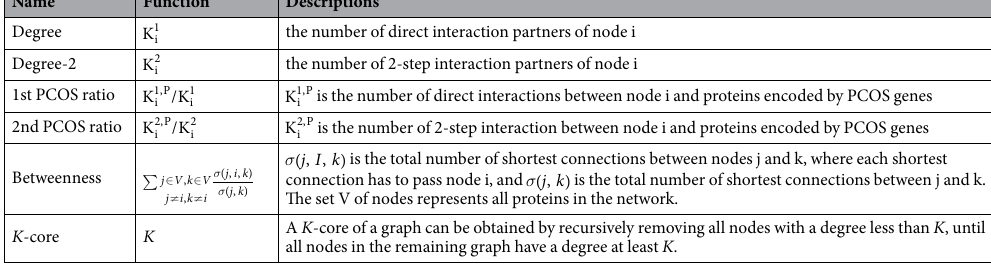
We tested different classifiers to predict PCOS genes: K -nearest neighbor (KNN), decision tree and SVM with different kernel functions. KNN and decision tree were employed from MATLAB, and SVM were employed from LIBSVM3.22 36 . As shown in the Results, SVM with linear kernel achieved the best performance.